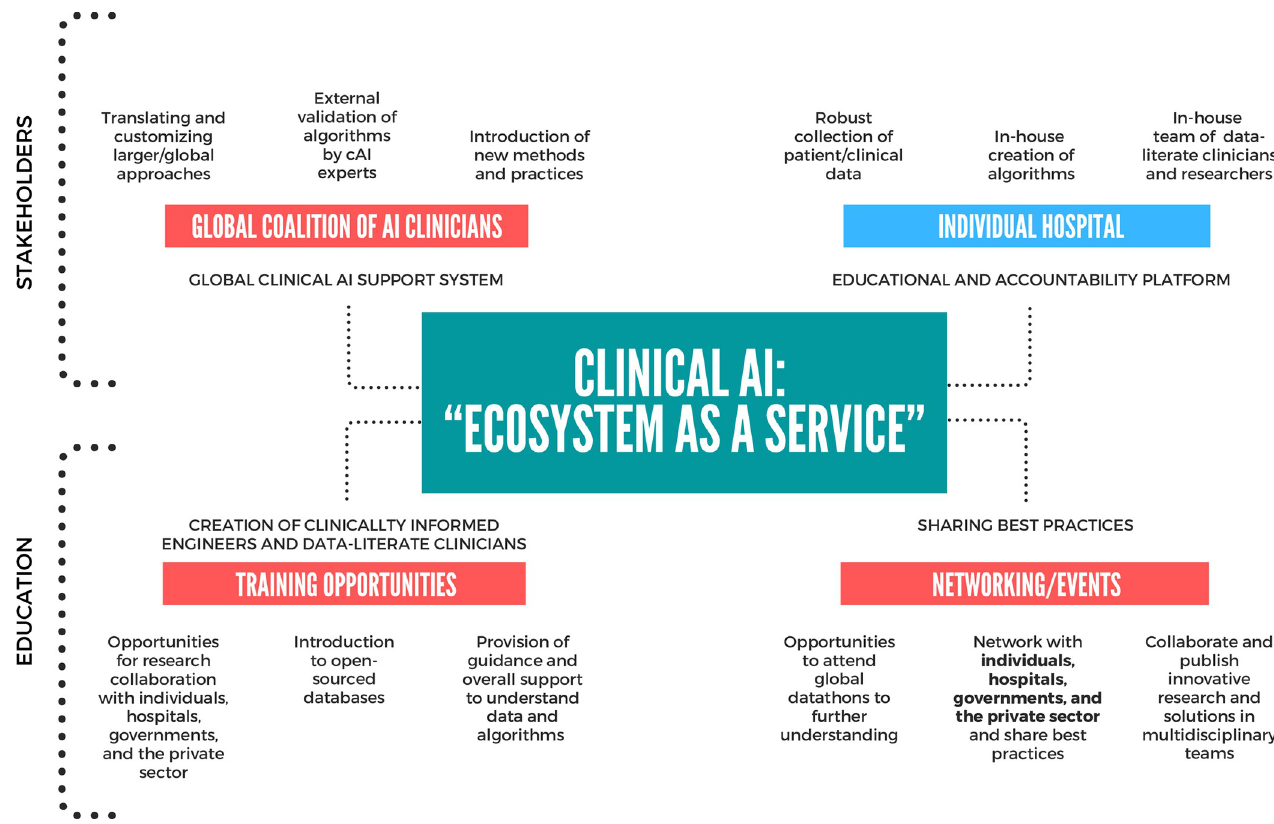
Fig 1. “Ecosystem as a service” for cAI. Overview of the EaaS approach for cAI with its three main components: 1. Global coalition of AI clinicians, 2. Training opportunities, and 3. Networking opportunities, integrated with an individual hospital system.